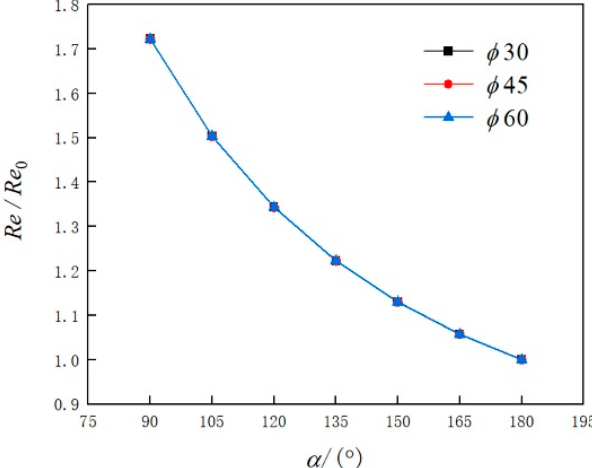
Figure 8. Relative Reynolds number Re / Re 0 changing with the central angle α for straight pipes.